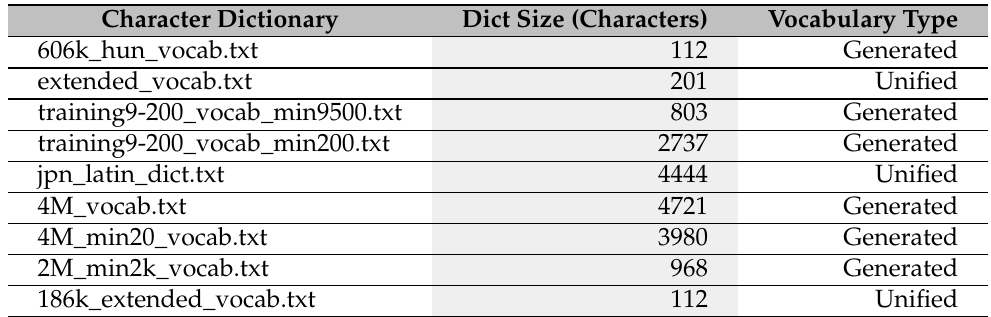
Table 2. Vocabulary sizes and